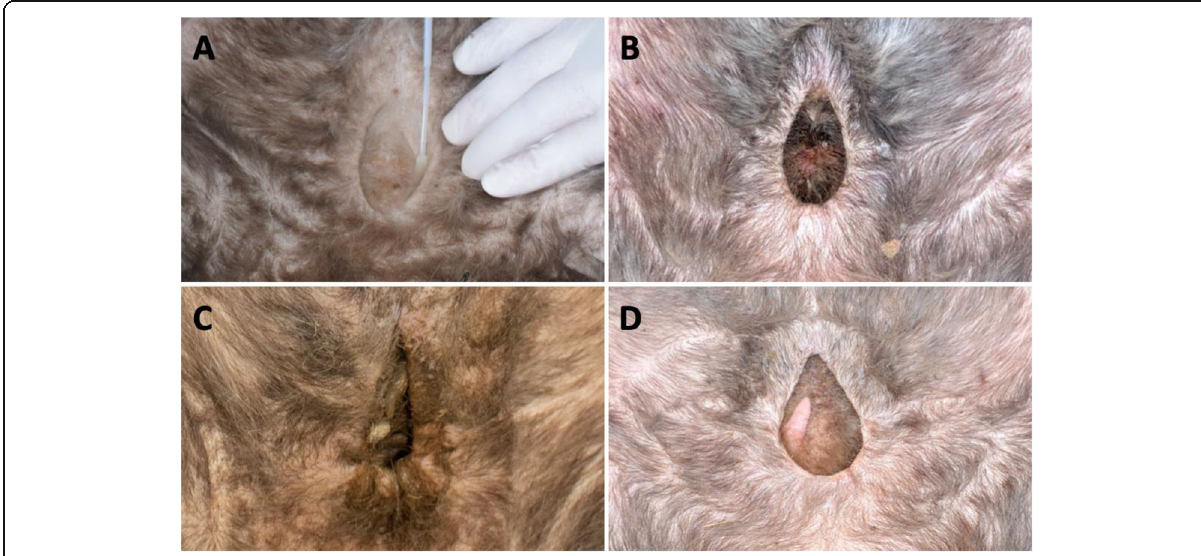
Fig. 2 Southern Hairy-nosed Wombat pouches during different reproductive stages. A) Subadult pouch, characterised by the dry, clean and shallow appearance. B) Pouch of an adult female either in oestrus or during gestation, characterized by being moist with dark red coloured secretions, deep, and with a thick muscular pouch wall. C) Pouch of an adult female during lactation, with a 5.5 months old joey inside, characterized by being moist, dirty, deep and with a tight pouch entrance. D) Pouch of an adult female early post lactation / anoestrus, with